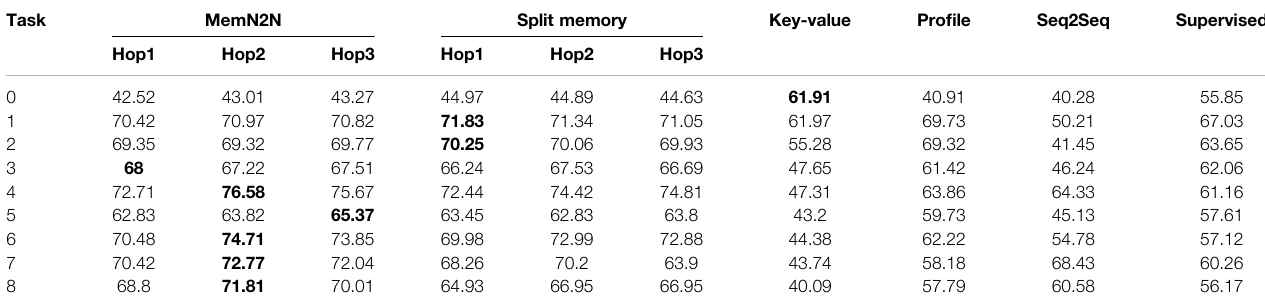
TABLE3| The test setresultsofthePersonalisedBaristaDatasetwith1,000dialogues.Thebestperformingmethods(ormethodswithin0.1%ofbestperforming)aregiven in bold for the per-response accuracy metric. The results show that on average and for task 8 (containing all tasks), MemN2N is the best performing model. Task MemN2N Split